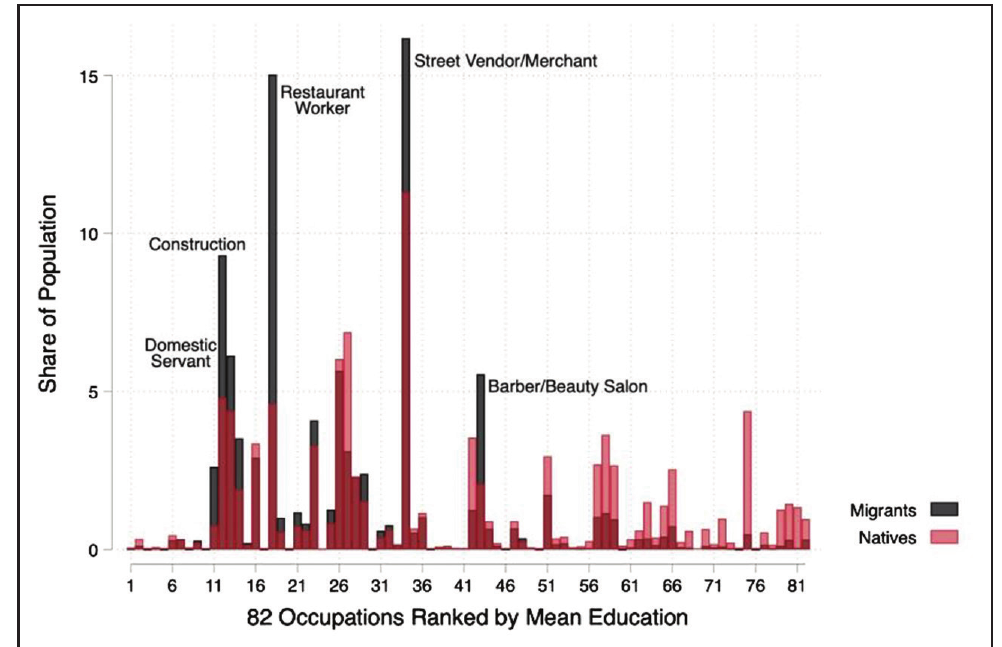
Figure A2 Concentration of migrants and natives across occupations.